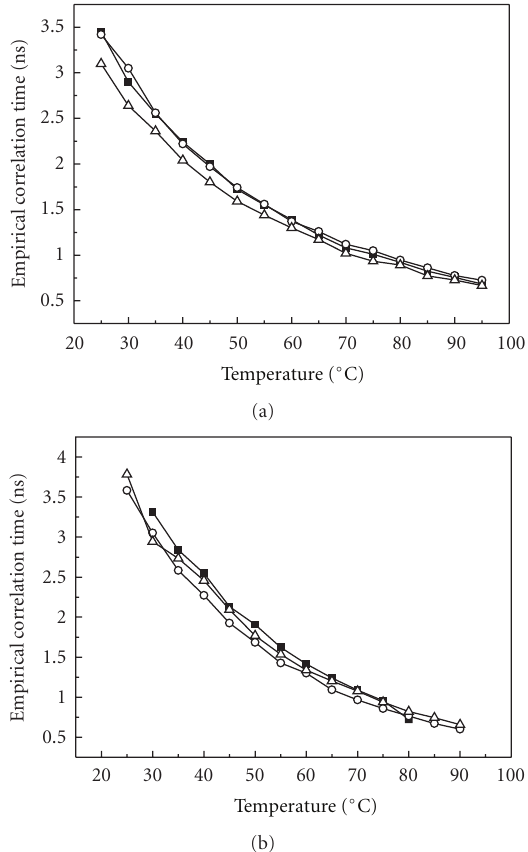
Figure 7: Temperature dependence of empirical correlation time ( τ c ) of MeFASL(10,3) in SUV archaeosomes prepared from PLMF lipids isolated from A. pernix grown in medium with di ff erent pH ( (cid:2) pH 6.0; (cid:6) pH 7.0; Δ pH 8.0) and measured at the same pHs (a) and at pH 7.0 (b). Empirical correlation time was calculated directly from the EPR spectra according to Equation (3).